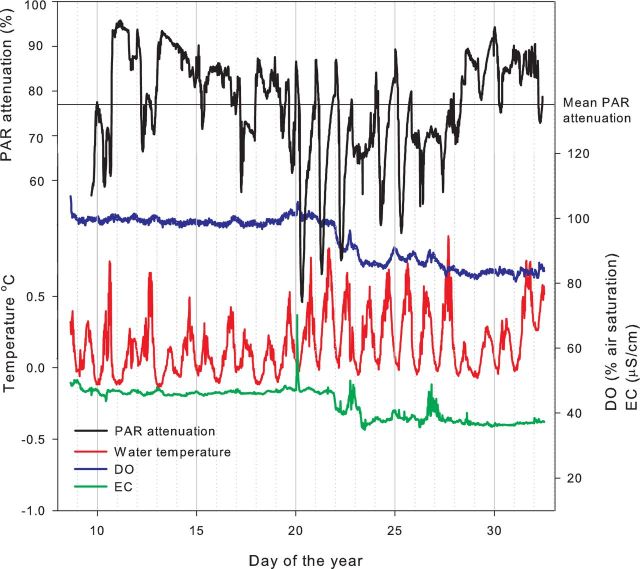

In situ measurements of water temperature, EC, DO and PAR attenuation (the fraction of PAR reaching the probe) in a cryolake on Joyce Glacier in January 2010.